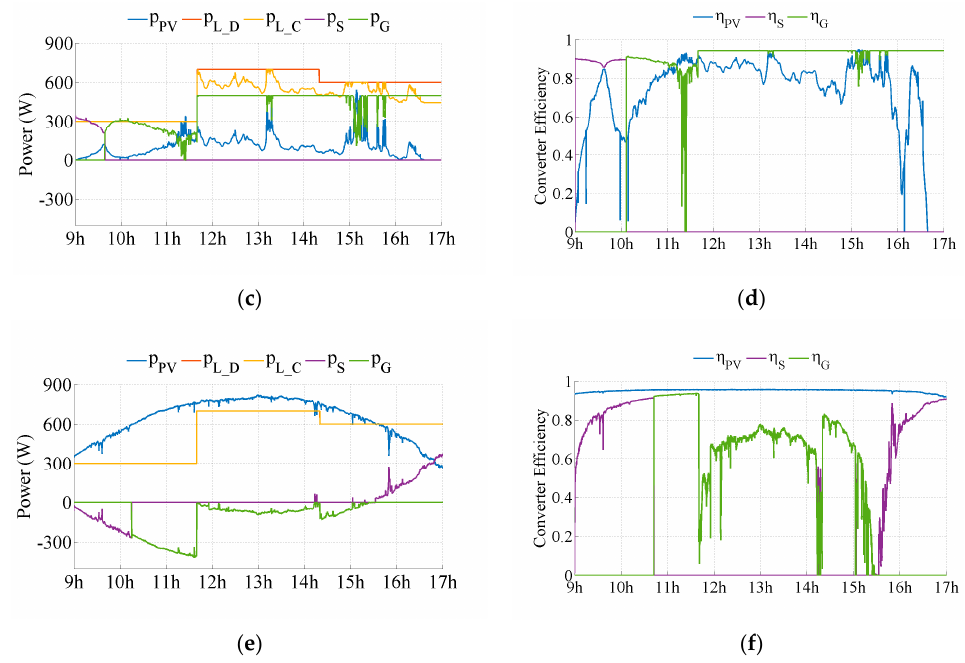
Figure 10. Power balancing with DCE and smaller PSM: ( a ) powers evolution and ( b ) DCE power for 13 November 2014; ( c ) powers evolution and ( d ) DCE power for 27 January 2015; ( e ) powers evolution and ( f ) DCE power for 12 March 2015.